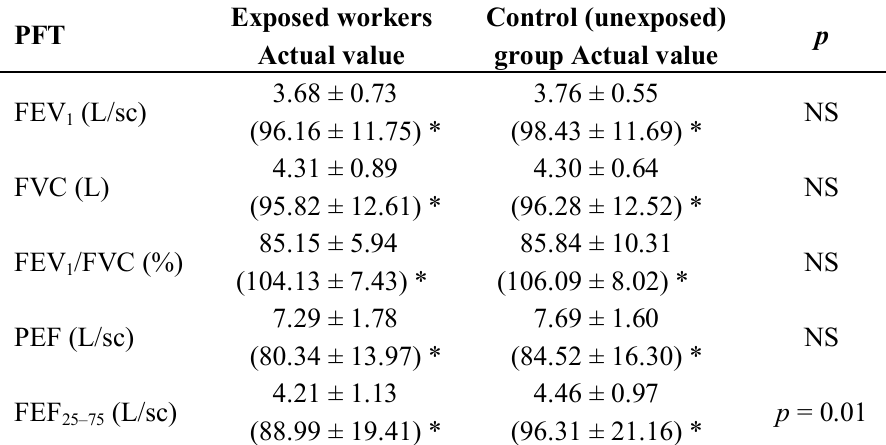
Table 5. The descriptive statistics (including Mean ± SD) and the significance levels of PFTs of the exposed workers and the control (unexposed)